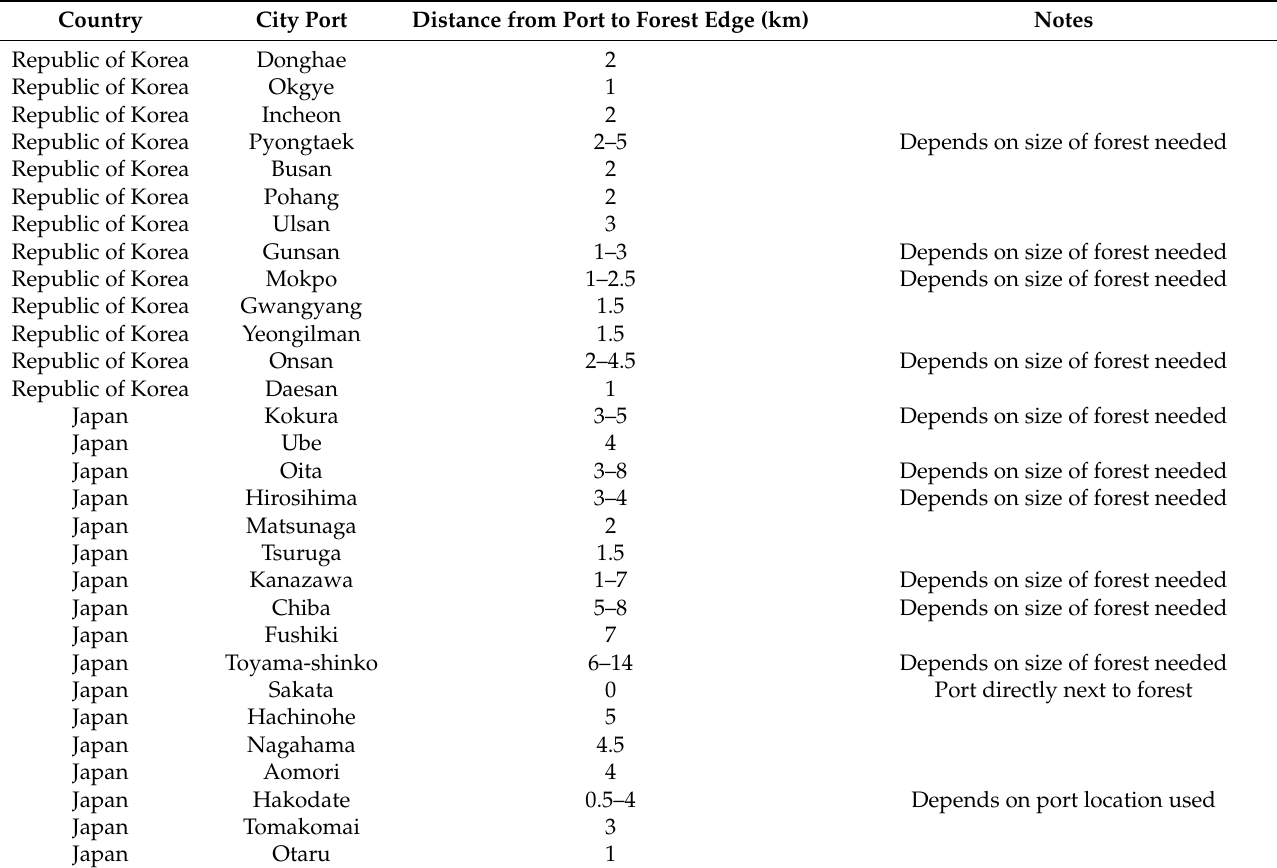
Table 3. Potential flight distance of gypsy moth populations from the Republic of Korea, Japan, and Russia. Country City Port Distance from Port to Forest Edge